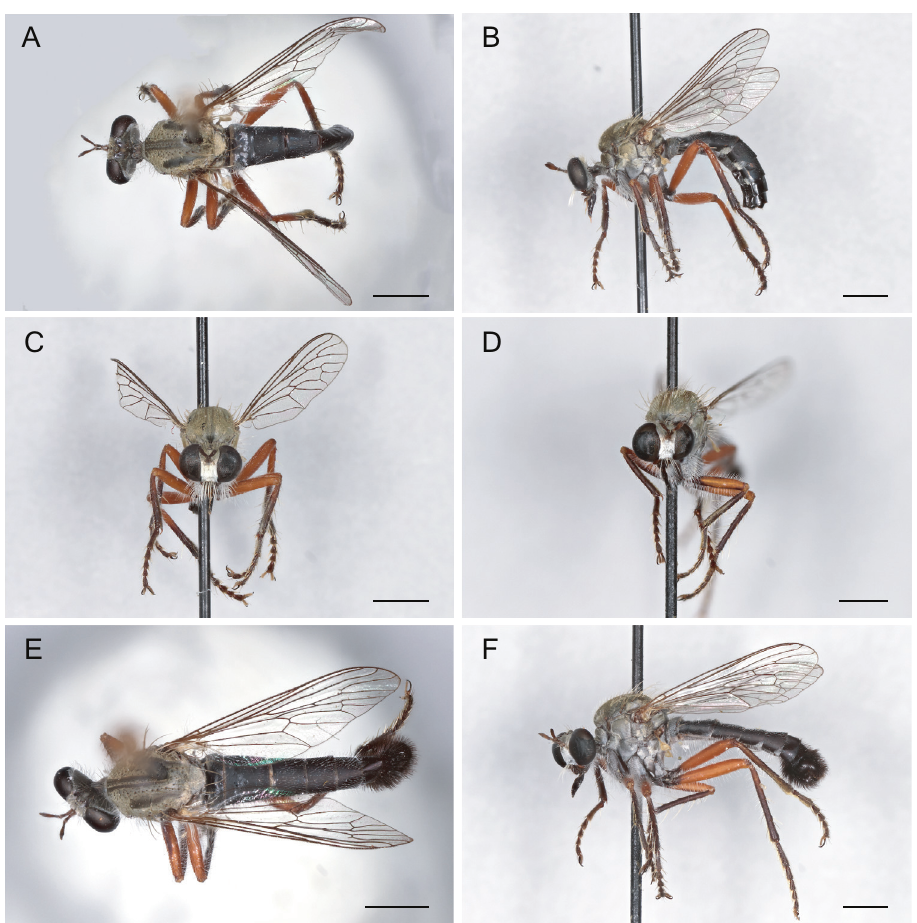
Figure 16. Saropogon laparoides Bromley, 1951 Female (USNMENT01819592): A dorsal view B lateral view C anterior view; Male (USNMENT01819567): D anterior view E dorsal view F lateral view. Scale bars: 2